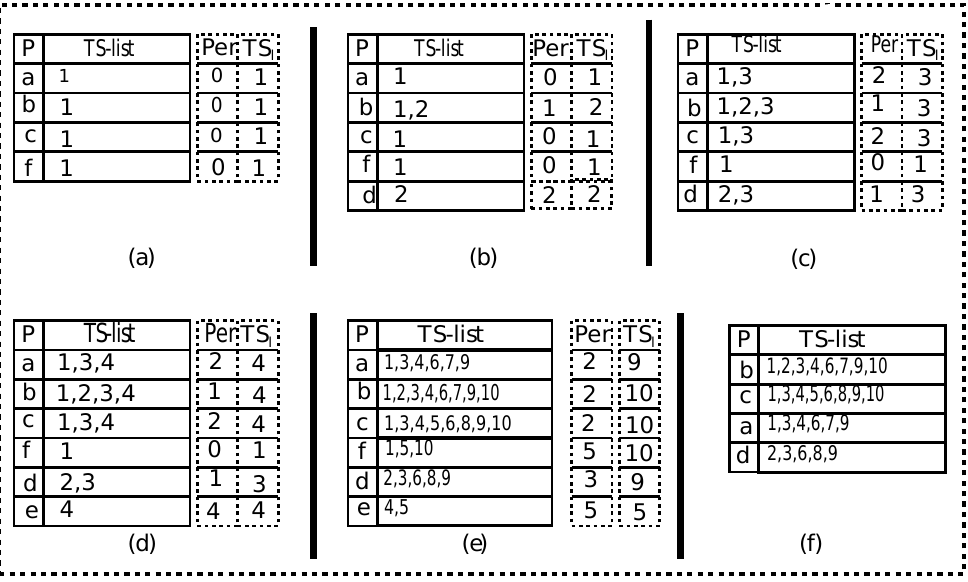
Figure 2. Finding periodic-frequent patterns. ( a ) after scanning the first transaction, ( b ) after scanning the second transaction, ( c ) after scanning the third transaction, ( d ) after scanning the fourth transac- tion, ( e ) after scanning the entire database, and ( f ) final list of periodic-frequent patterns sorted in descending order of their support (or the size of